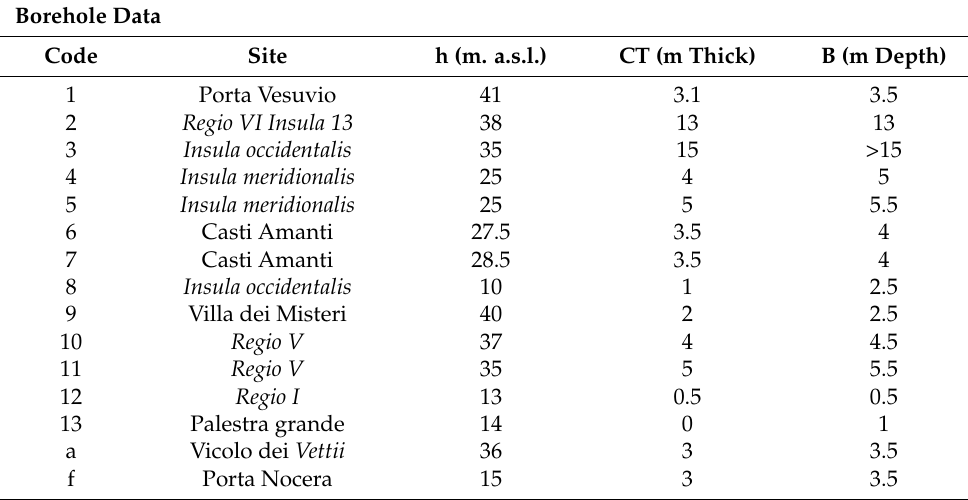
Figure 7. Geomorphological zonation (GM): ( A ) unstable zones; ( B ) stable zones prone to local amplification; ( C ) stable zones. Table 1. Stratigraphical data from boreholes with indication of the CT thickness and B depth from the 79 AD ground